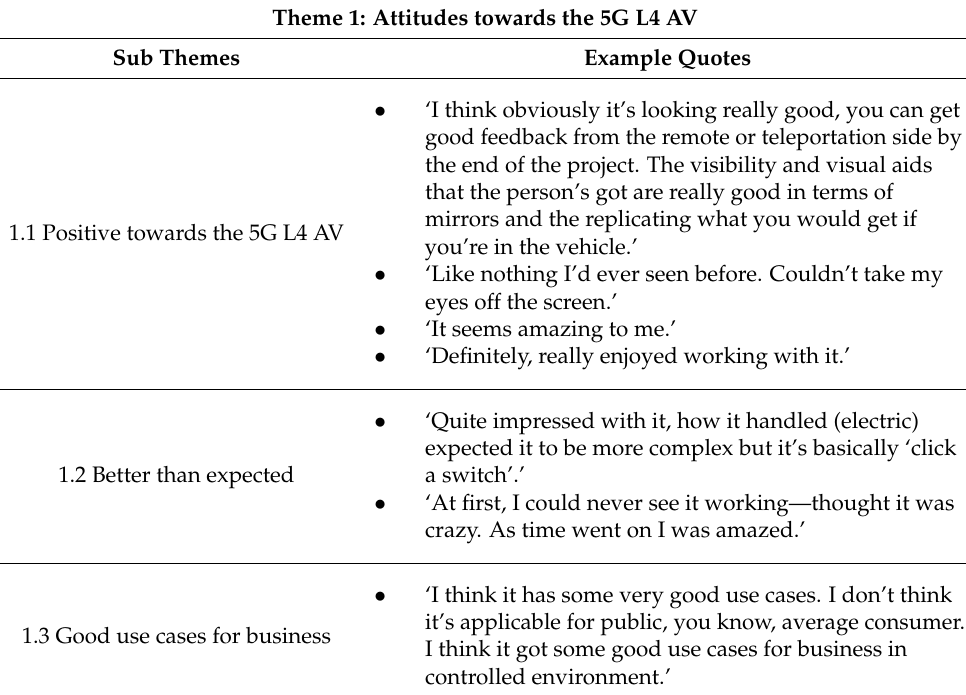
Table 1. Theme 1: Remote drivers’ attitudes towards the 5G L4